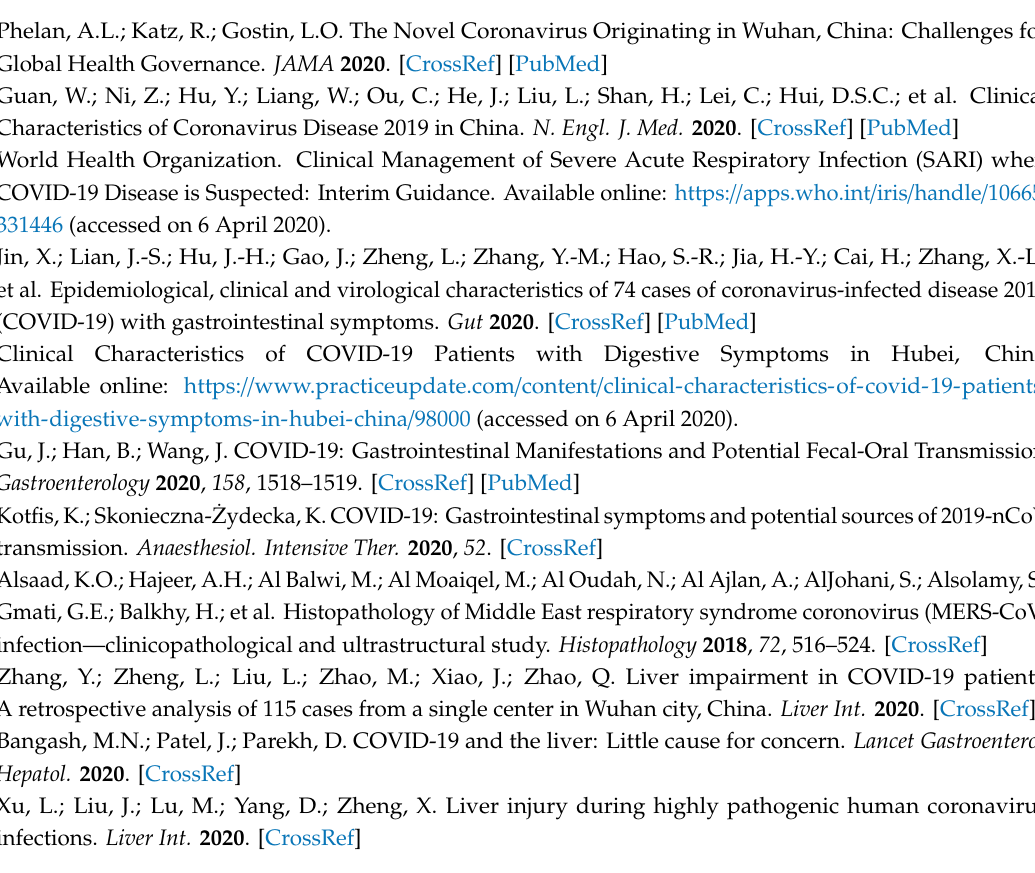
Table S1: Risk of bias